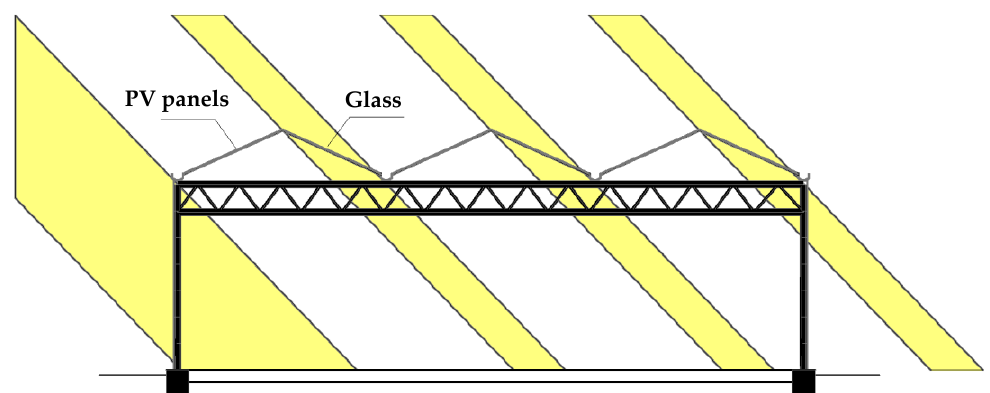
Figure 3. Direct solar radiation at Mediterranean latitudes: 21 September, 12:00 pm.